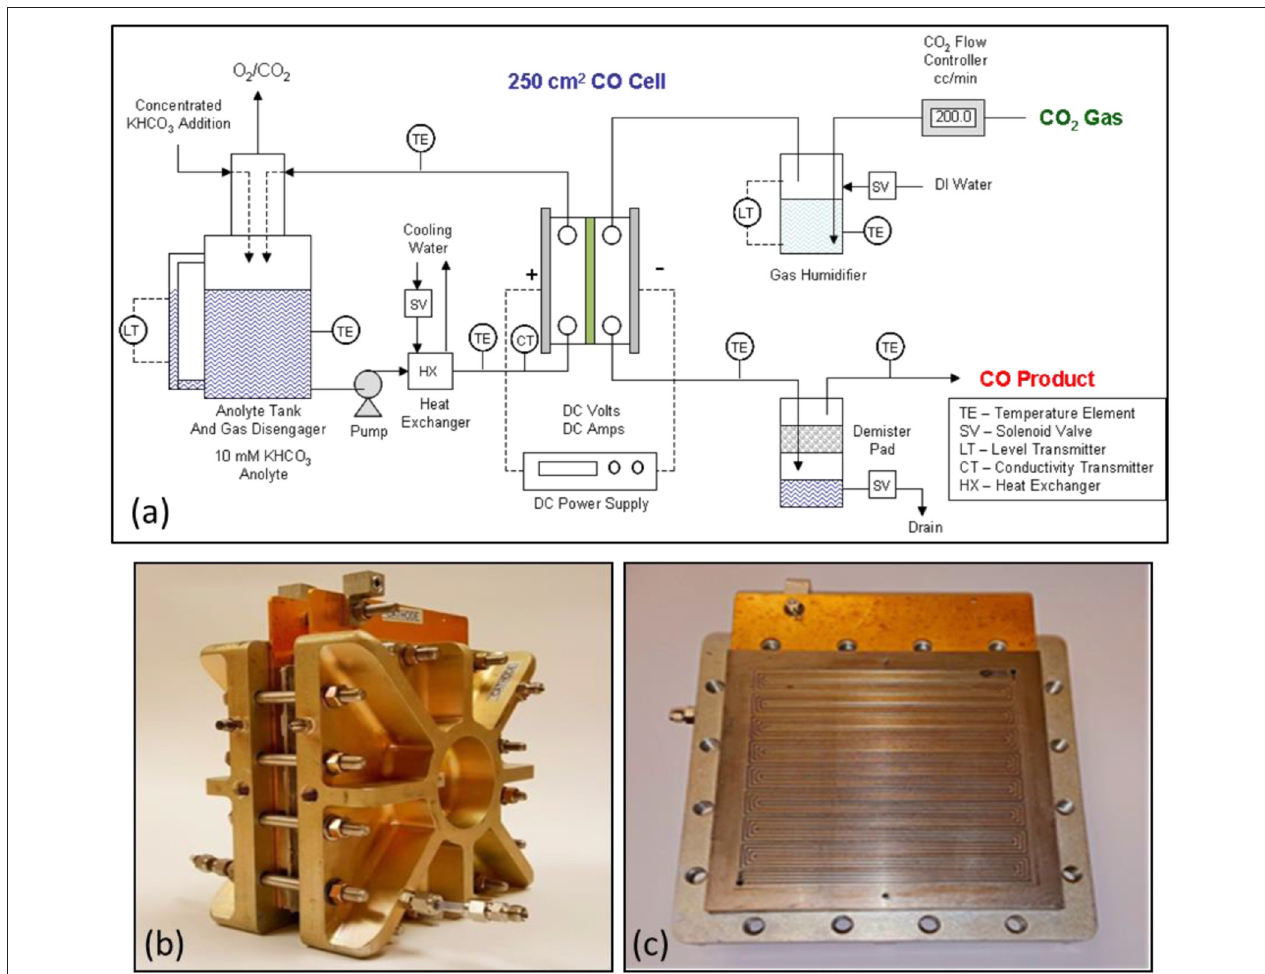
FIGURE 9 | Schematic of the 250 cm 2 CO 2 cell experimental test system is shown in (a) . The DM modified 250 cm 2 CO 2 electrolyzer cell as shown in (b) on the left. The design used a titanium serpentine anode flow field design as shown in (c) .